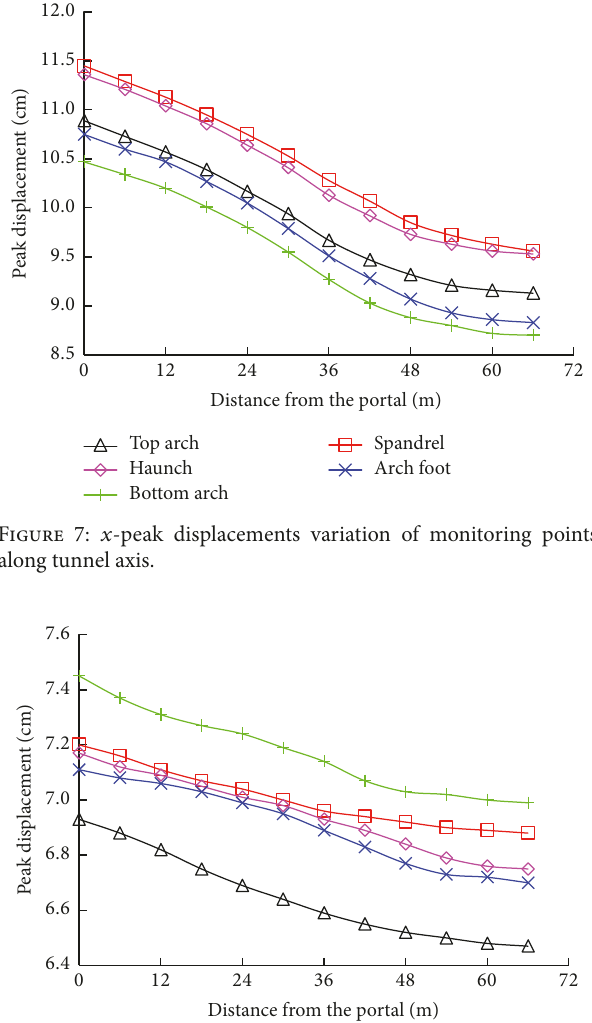
Figure 6: Monitoring points’ layout of lining.